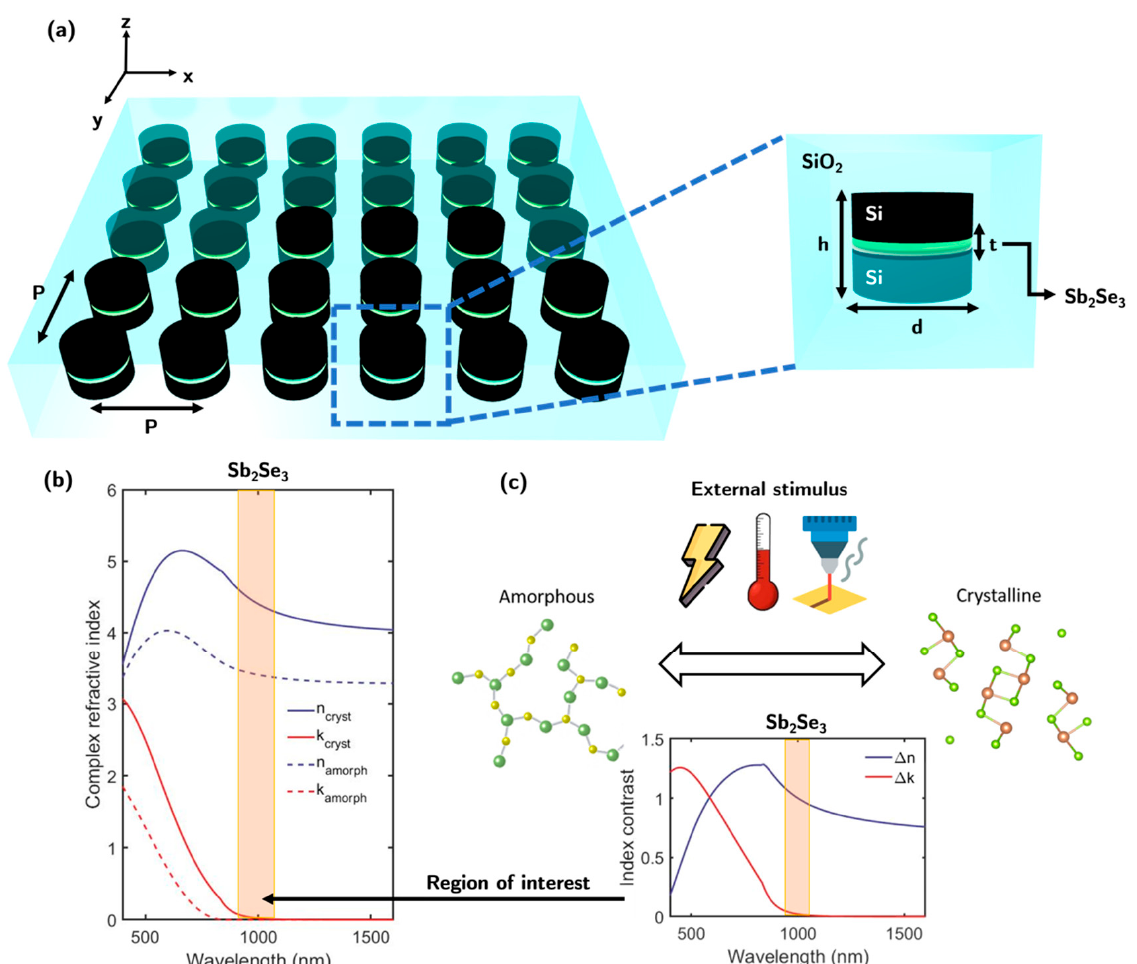
Figure 1. ( a ) A sketch of the reconfigurable metasurface proposed in this work. ( b ) The complex refractive index ( m = n + ik ) of Sb 2 Se 3 amorphous and crystalline phases. ( c ) Scheme of the phase transformation (amorphous to crystalline) of Sb 2 Se 3 through external stimulus such as, temperature, current, or pulse laser. Refractive index contrast ( ∆ n = n cryst − n amorph and ∆ k = k cryst − k amorph ) between crystalline and amorphous phases. The operational region of interest is shadowed in orange.